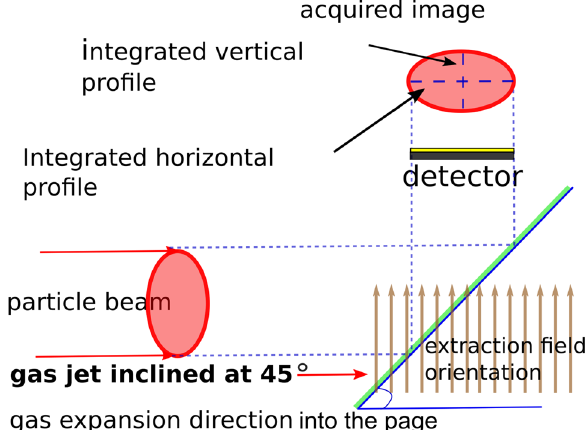
FIG. 1. Principle of two-dimensional imaging (ions are ex- tracted by the external electric